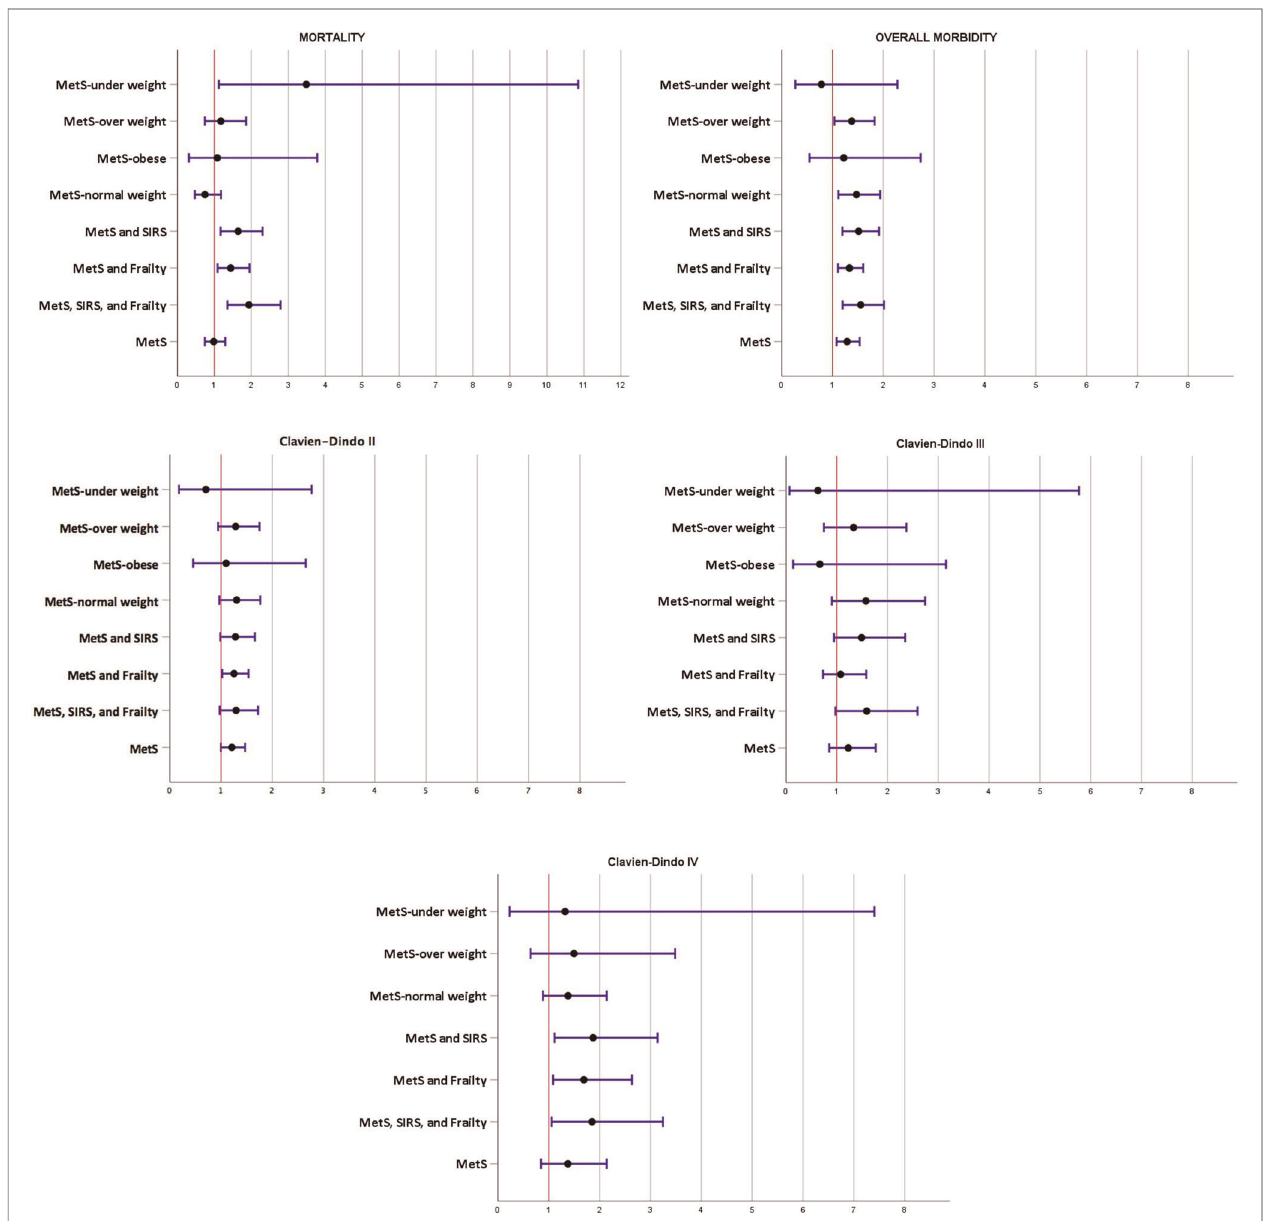
FIGURE 1 | Bars showing the adjusted OR on 30-day mortality and morbidity strati fi ed for BMI class, SIRS, and frailty. The error bars represent 95% con fi dence intervals